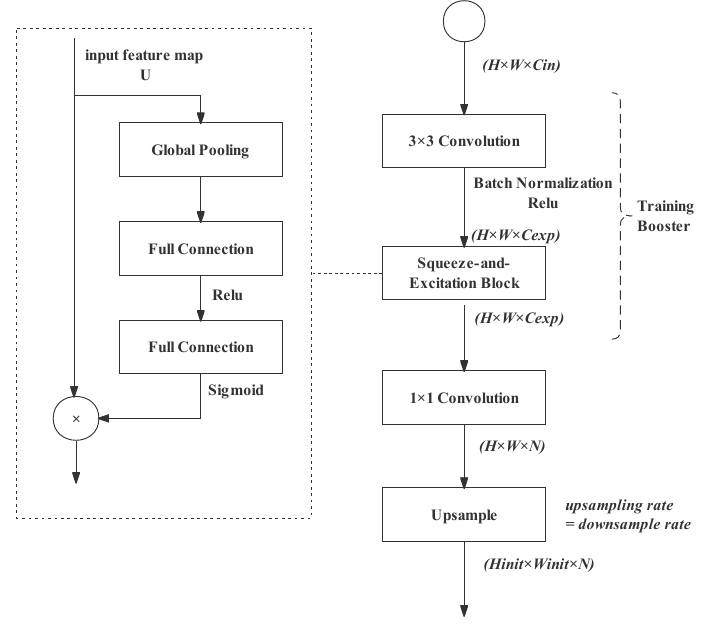
Figure 13. Training boosting